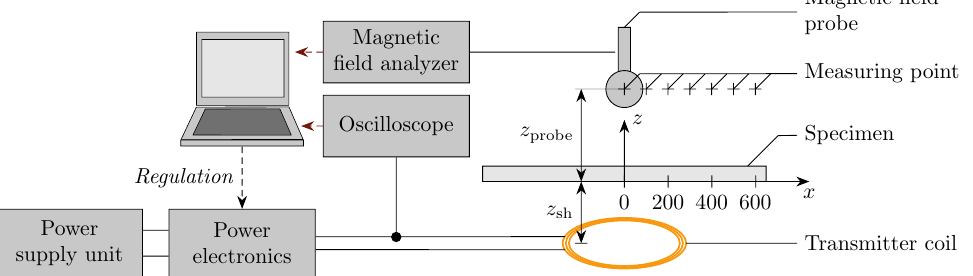
Figure 8. Experimental setup for the determination of the shielding effectiveness of metal